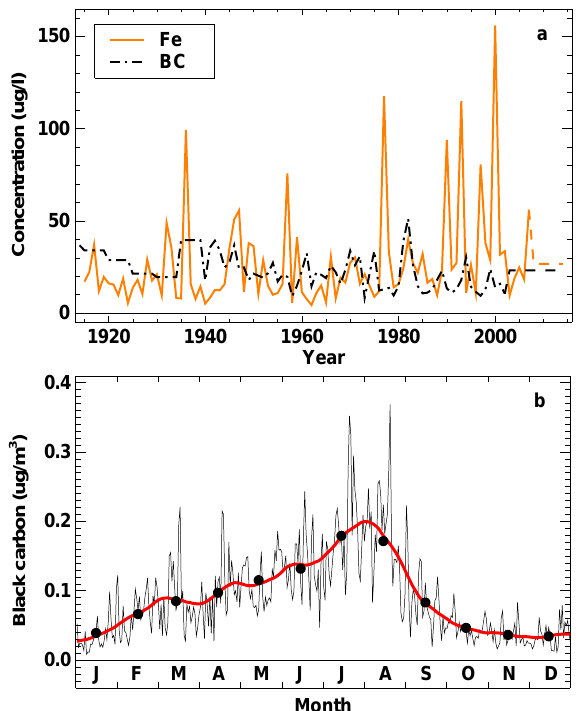
Figure 2. (a) Concentrations of Fe (Sigl, 2009) and BC (inferred from EC; Jenk et al., 2006) over the period 1914–2014 retrieved from the Colle Gnifetti and Fiescherhorn ice core, respectively (Fig. 1). (b) Mean annual cycle of BC concentrations in the atmo- sphere measured by GAW at Jungfraujoch averaged over the years 1995–2000. Dots refer to the monthly means, and the solid red line refers to the running